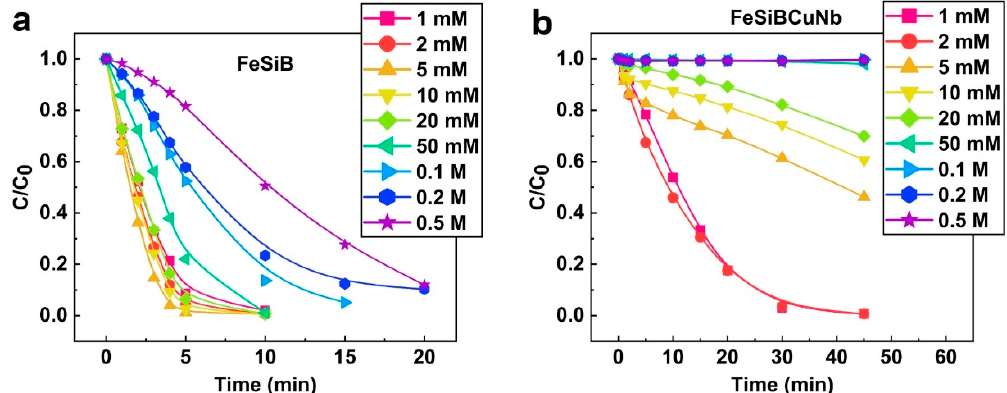
Figure 6. Effect of H 2 O 2 concentrations from 1 mM to 0.5 M using ( a ) Fe 78 Si 9 B 13 (FeSiB) and ( b ) Fe 73.5 Si 13.5 B 9 Cu 1 Nb 3 (FeSiBCuNb) metallic glass ribbons at acidic condition (MO dye concentration: 20 ppm, catalyst dosage: 0.5 g/L, pH 3.0, 25 °C). Decolorization rates were measured from the λ max of the corresponding UV-Vis spectra with reaction time.